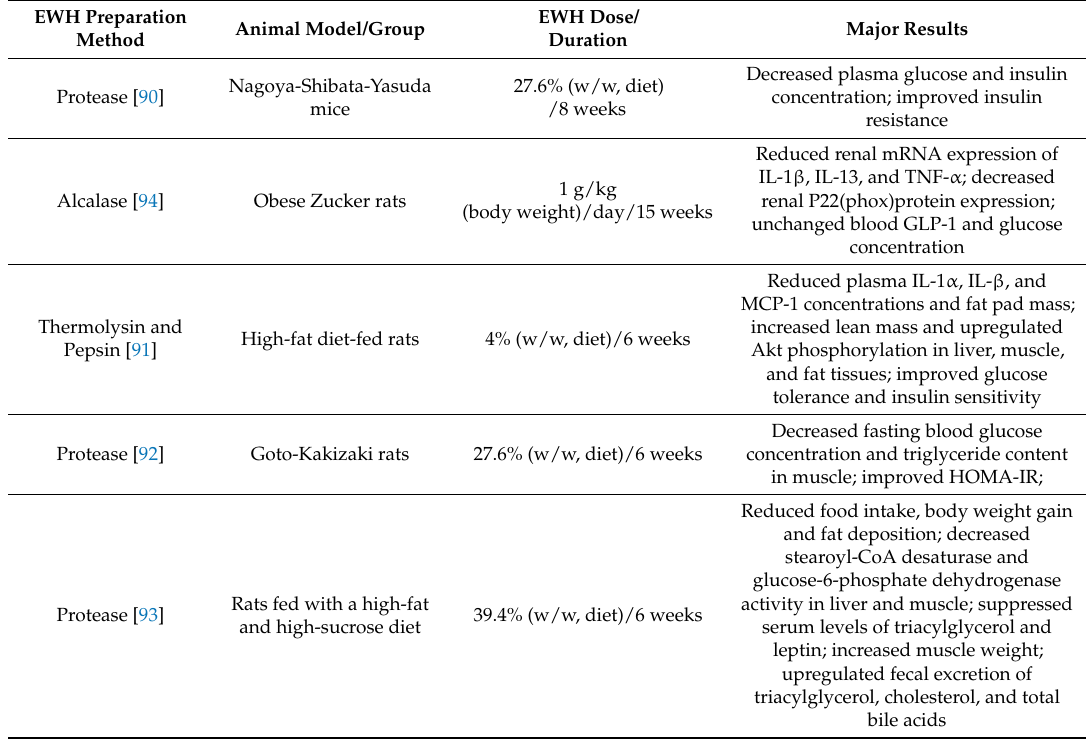
Table 2. In vivo studies of the effect of EWH on